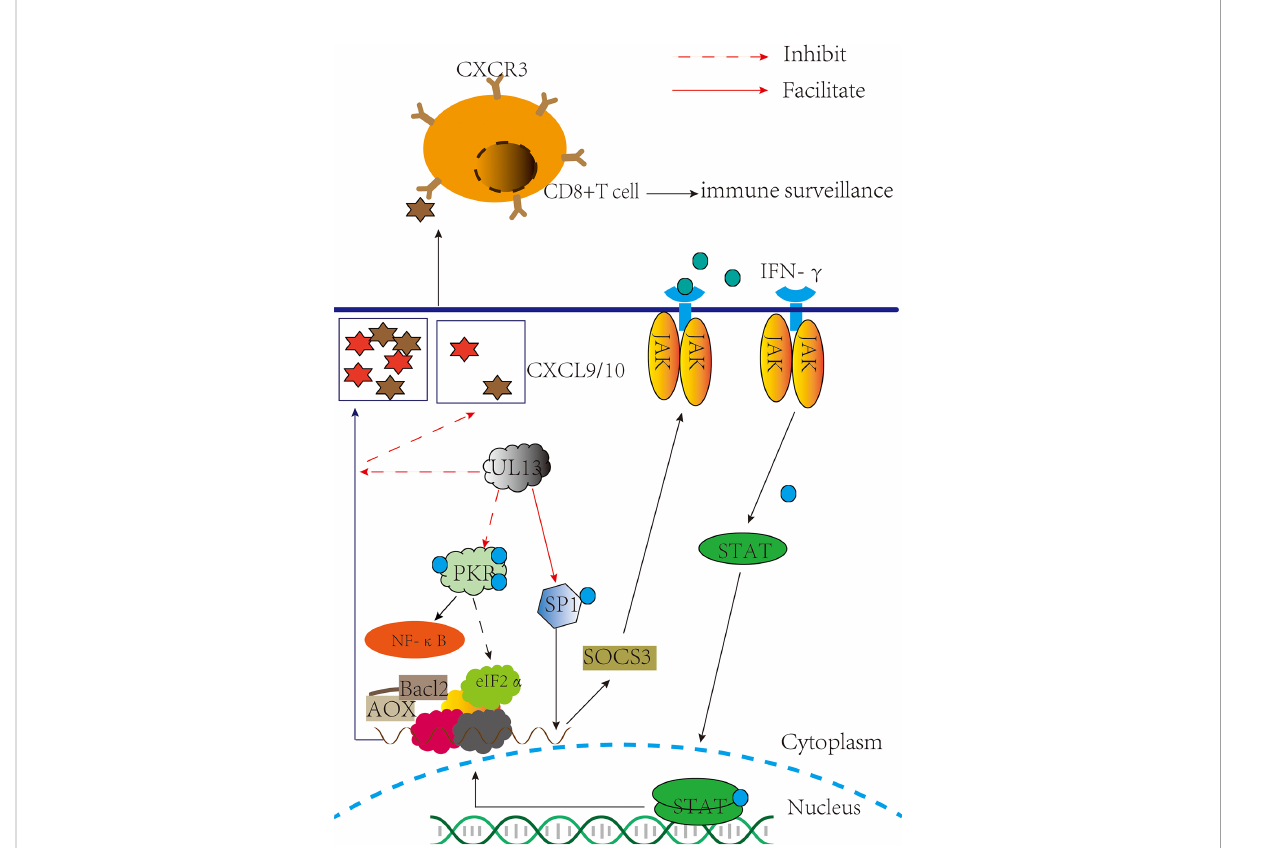
FIGURE 2 pUL13 inhibits PKR, CD8+ T cells, and the JAK-STAT signaling pathway to evade innate immunity. pUL13 inhibits PKR phosphorylation to evade innate immunity and promotes viral protein translation with eukaryotic initiation factor 2 a (eIF2 a ); pUL13 phosphorylates the associated constitutive transcription factor SP1 (SP1), which induces suppressor of cytokine signaling 3 (SOCS3) expression to inhibit the JAK-STAT signaling pathway; and pUL13 can down-regulate the C-X-C motif chemokine ligand 9 (CXCL9) signaling molecules to prevent cd8+ T cell molecules from clustering at the site of